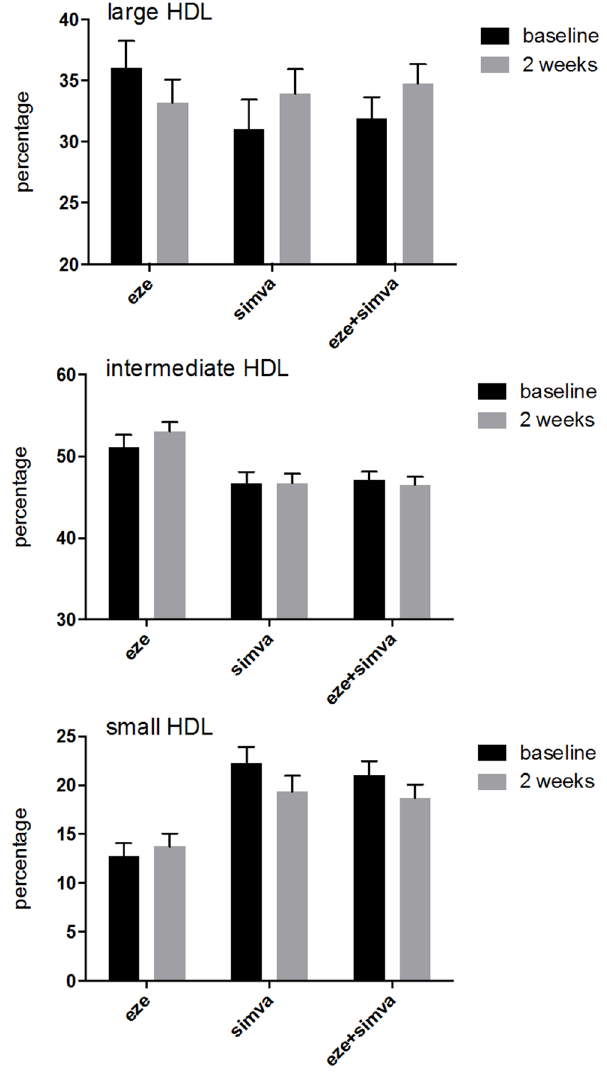
Figure 3. Mean (95% confidence intervals) proportions of HDL subclasses before and 2 weeks after treatment. (A) large HDL, (B) intermediate HDL, (C) small HDL.